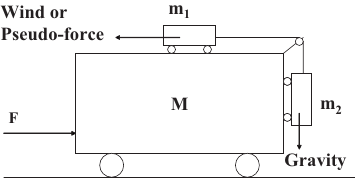
FIG. 1. Novices’ and experts’ problem representation from